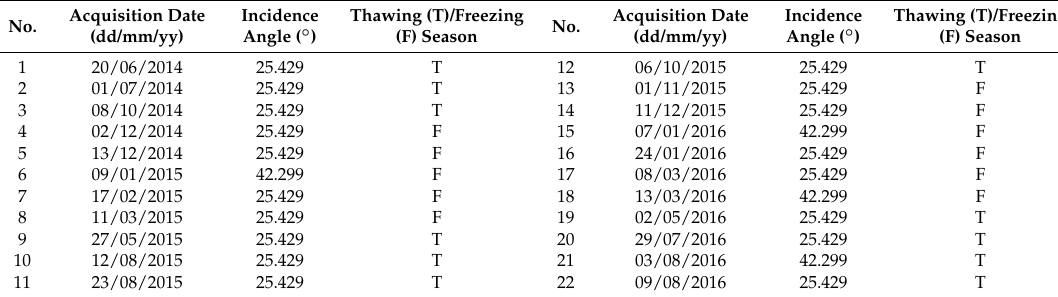
Table 1. Parameters of the TerraSAR-X images.